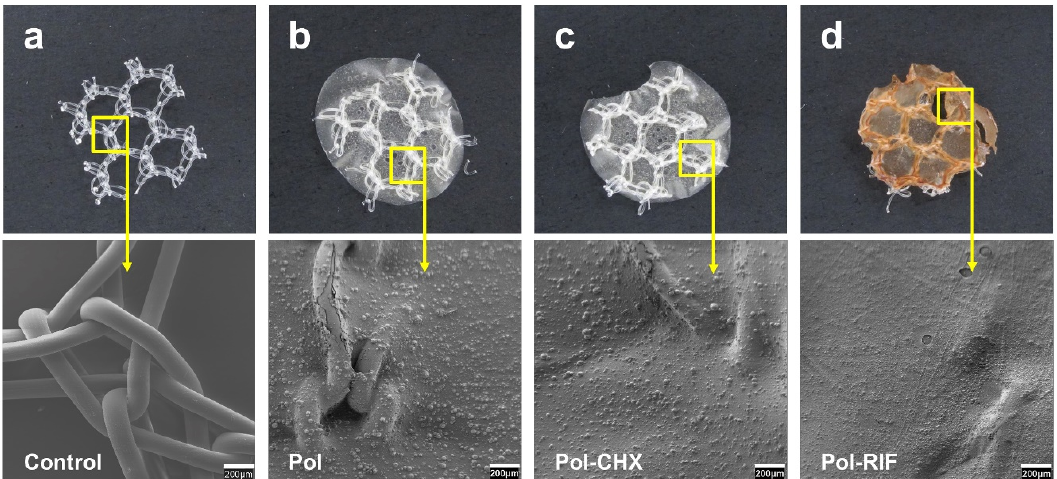
Figure 2. Macroscopic pictures and SEM micrographs (scales: 200 µ m) of ( a ) nude control meshes, ( b ) meshes coated with the unloaded biocomposite (Pol), ( c ) meshes coated with chlorhexidine-loaded biocomposite (Pol-CHX), and ( d ) meshes coated with the rifampicin-loaded biocomposite (Pol-RIF).